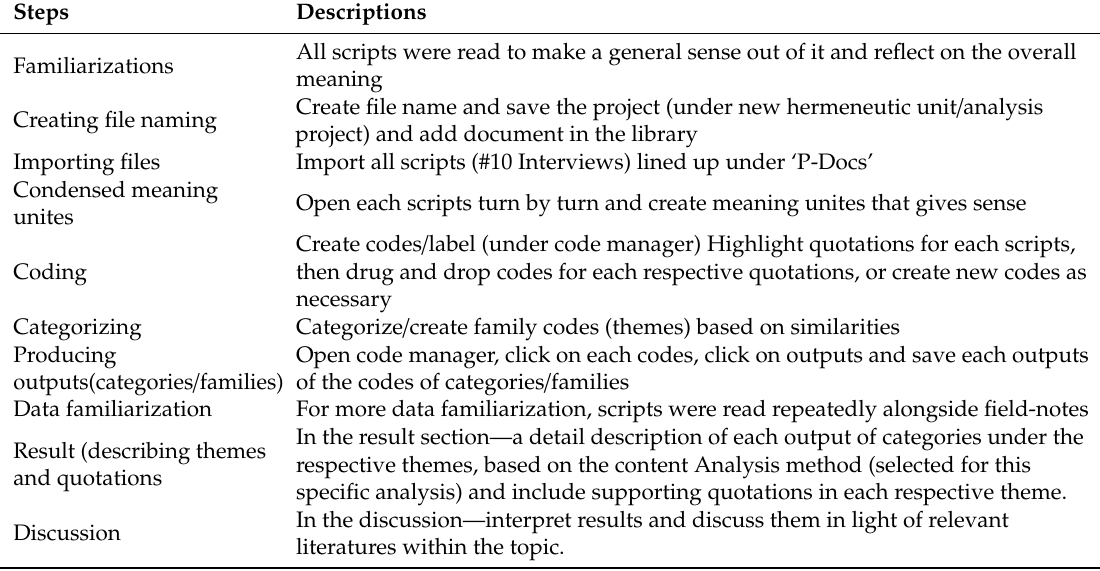
Table 2. Procedures / steps of data analysis in Atlas Ti, based on the content